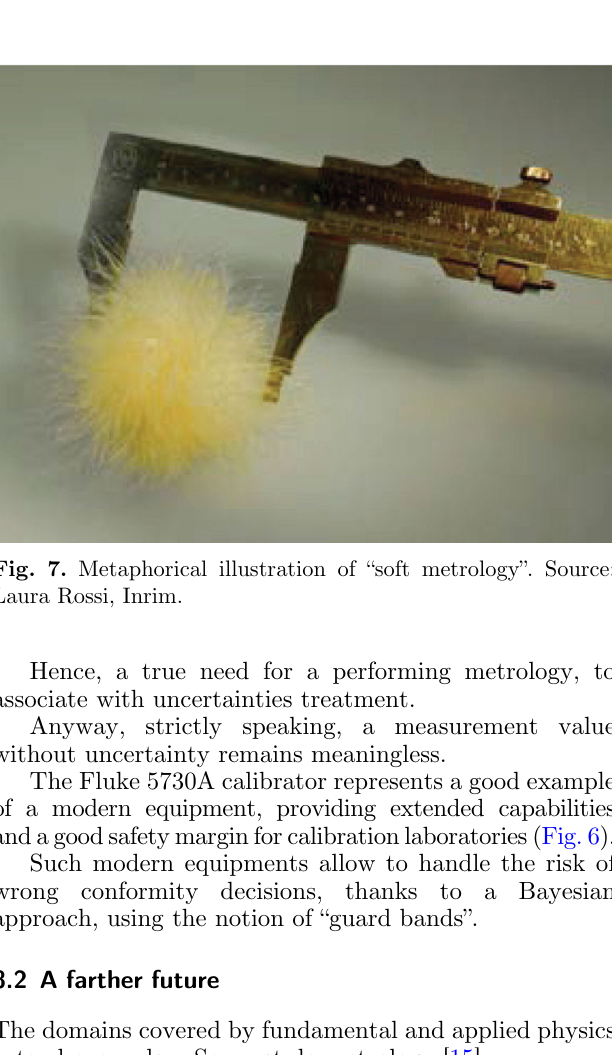
Fig. 6. 5730A calibrator.